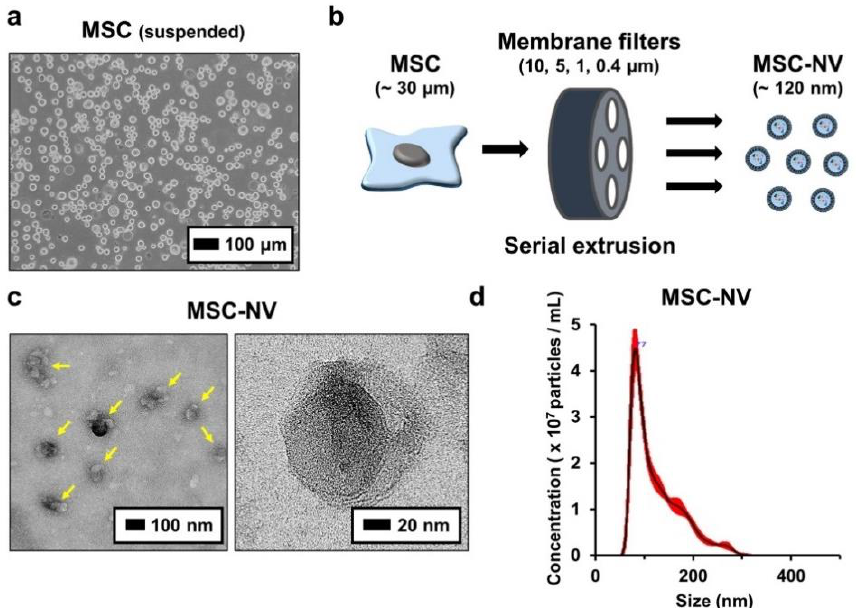
Figure 1. ( a ) Morphological observation of human bone marrow derived mesenchymal stem cells (MSCs). Suspended MSCs were observed using optical microscopy. ( b ) Schematic illustration showing the fabrication of MSC-engineered nanovesicles (MSC-NVs) by serial extrusion of MSCs. ( c ) TEM image of MSC-NVs. The yellow arrows in the left panel indicate MSC-NVs. ( d ) Size distribution of isolated MSC-NVs, determined by nanoparticle tracking analysis (NTA).